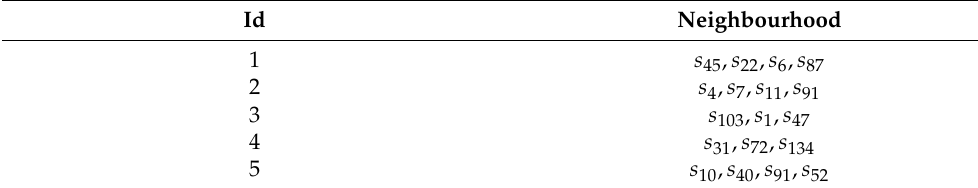
Table 1. Example of neighbourhoods definition.